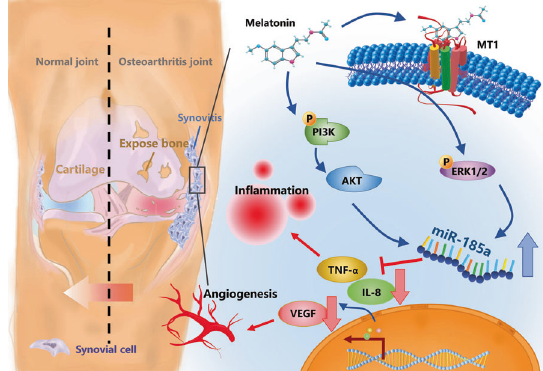
Fig. 6 The schematic diagram summarizes the mechanism whereby melatonin inhibits TNF- α , IL-8, and VEGF production. Melatonin attenuates TNF- α , IL-8, and VEGF expression by targeting the MT 1 receptor and thus inhibits the PI3K/Akt and ERK signaling pathways, leading to upregulation of miR-185a expression in human and rat OA